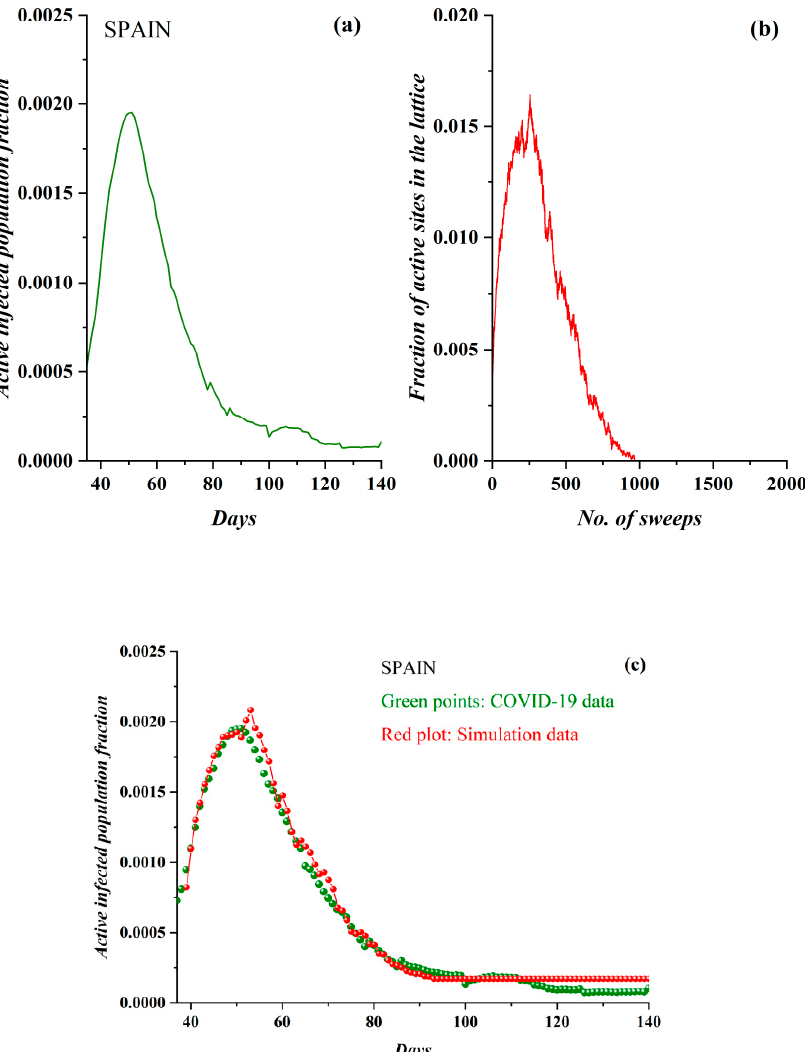
Figure 9. ( a ) The fraction of the active COVID-19-infected population daily in Spain (from 1 March 2020). ( b ) The fraction of active lattice sites; the simulation vs. the number of lattice sweeps is shown. ( c ) The COVID-19 epidemic data in green points, fitted by the proposed the SODM simulation data, in red points. In the case of Spain, each day corresponds to 18 sweeps.